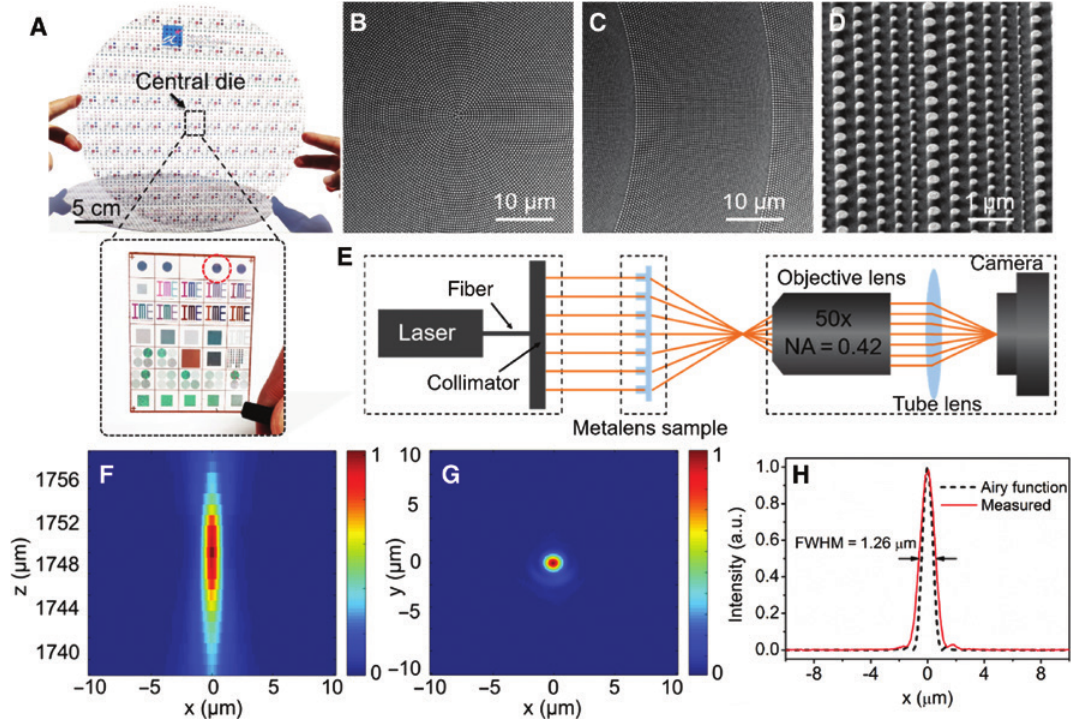
Figure 3: Characterization of the metalens fabricated on a 12-inch glass wafer. (A) Color photographs of the fabricated 12-inch glass wafer and the central die in the wafer with highlighted area indicating the metalens. SEM images at the (B) central, (C) near-central, and (D) outer zones of the metalens. (E) Schematic of the metalens characterization setup (not to scale). Measured optical intensity of the metalens at the optical (F) propagation plane and (G) focal plane. (H) Horizontal cut of the focal spot shown in (G). An ideal Airy function with aperture of 2 mm and focal length of 1.75 mm is